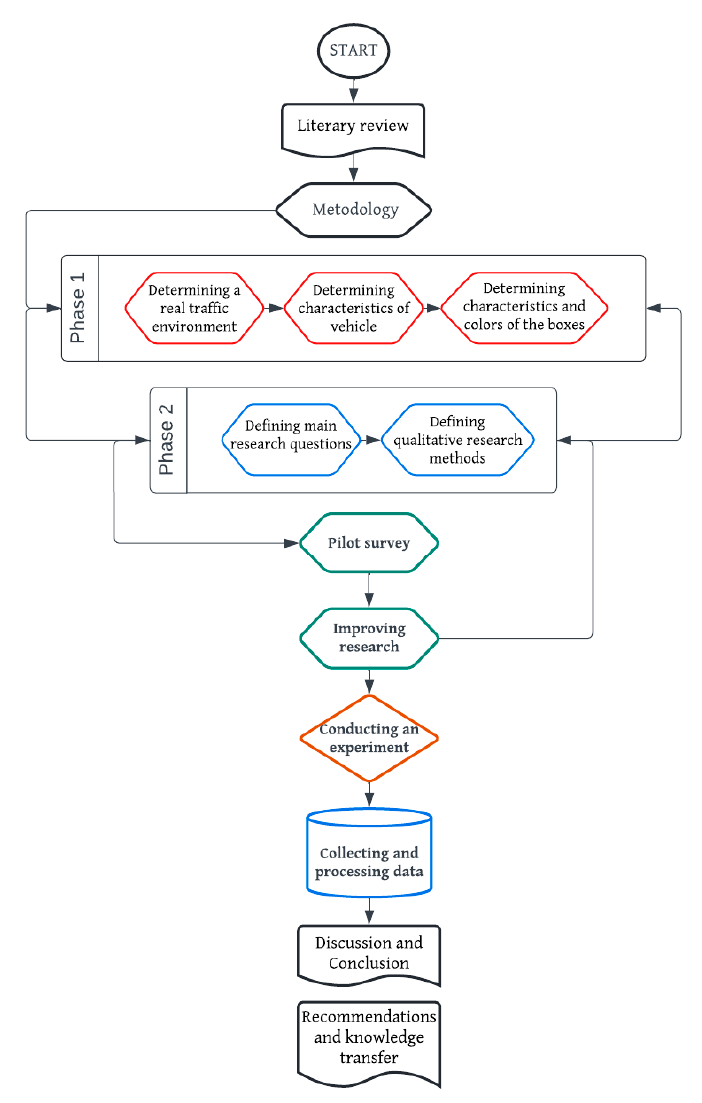
Figure 1. Flowchart research method diagram.